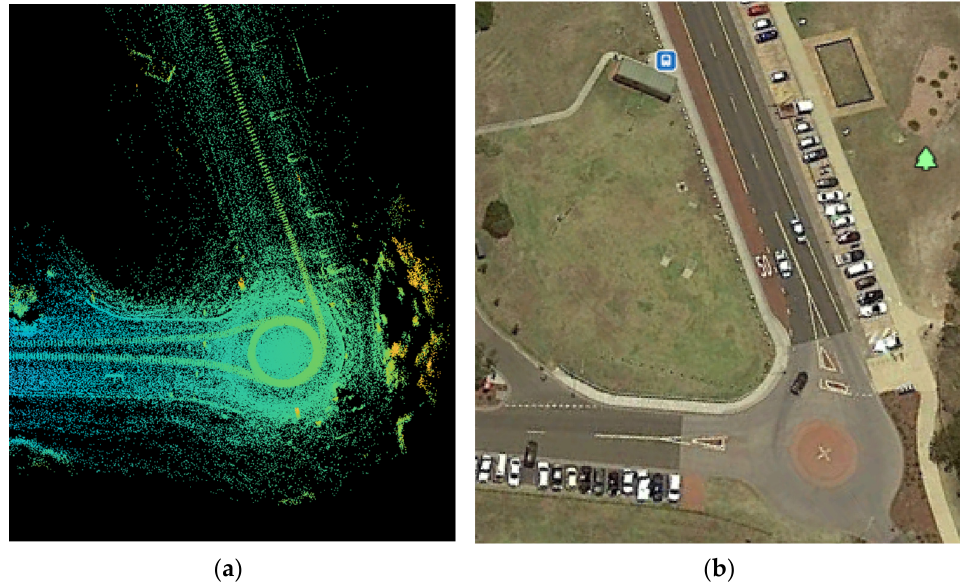
Figure 16. A section of ( a ) the generated map, and ( b ) the Google Earth view for the same location around the roundabout.